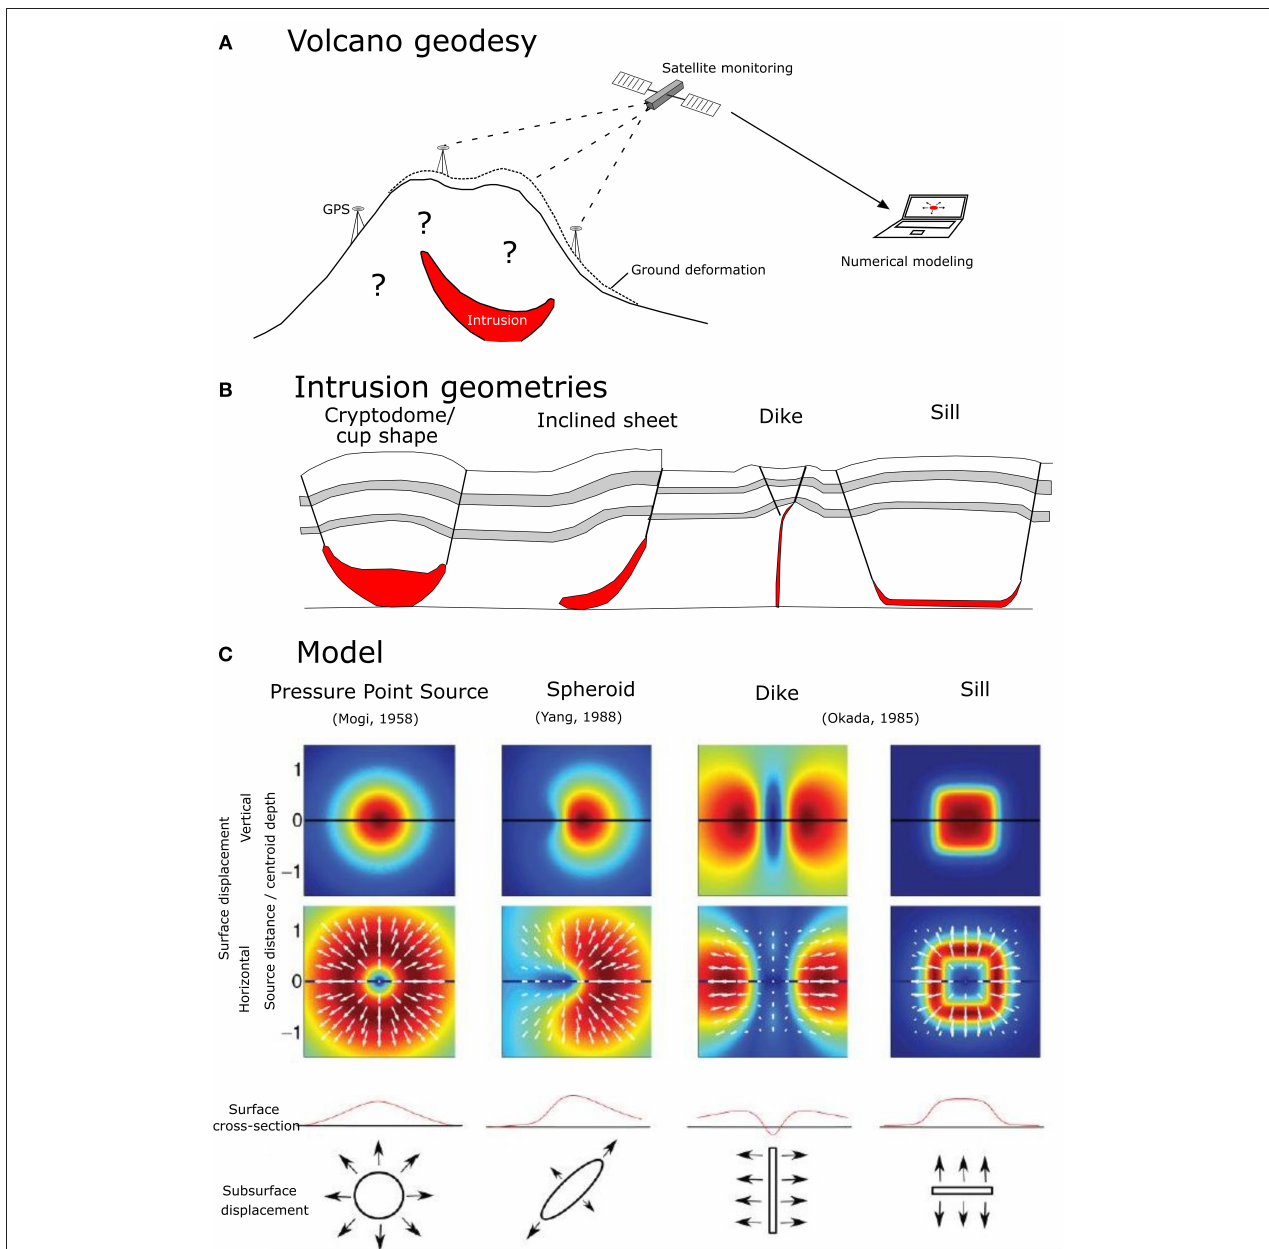
FIGURE 1 | (A) Subsurface geometrical growth of a magma intrusion can only be derived indirectly through numerical modeling of observations of seismicity or geodetic monitoring of the induced ground deformation using satellite monitoring (GPS, InSAR) or photogrammetry; (B) Geometries of now-chilled magma intrusions as observed at natural outcrops vary widely in geometry, ranging from thick cryptodomes and cup shapes over inclined sheets and cone sheets to thin vertical (i.e., dikes) and horizontal (i.e., sills) sheet intrusions (adapted from Schmiedel et al., 2017); (C) Geodetic models invert measured ground deformation to obtain best-fit magmatic deformation sources (i.e., intrusions) using a range of simplified geometries, ranging from Mogi point-sources to rectangular Okada sources (adapted from Sigmundsson et al.,